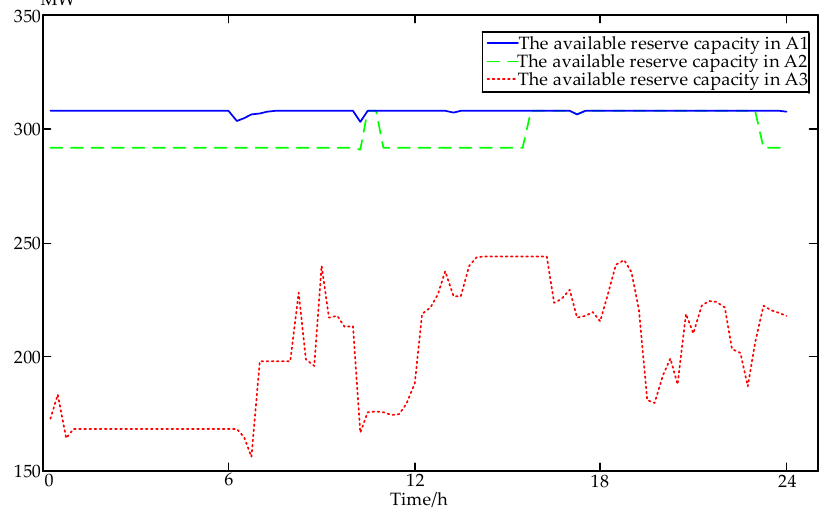
Figure 7. The available reserve capacities in the three presented cases.